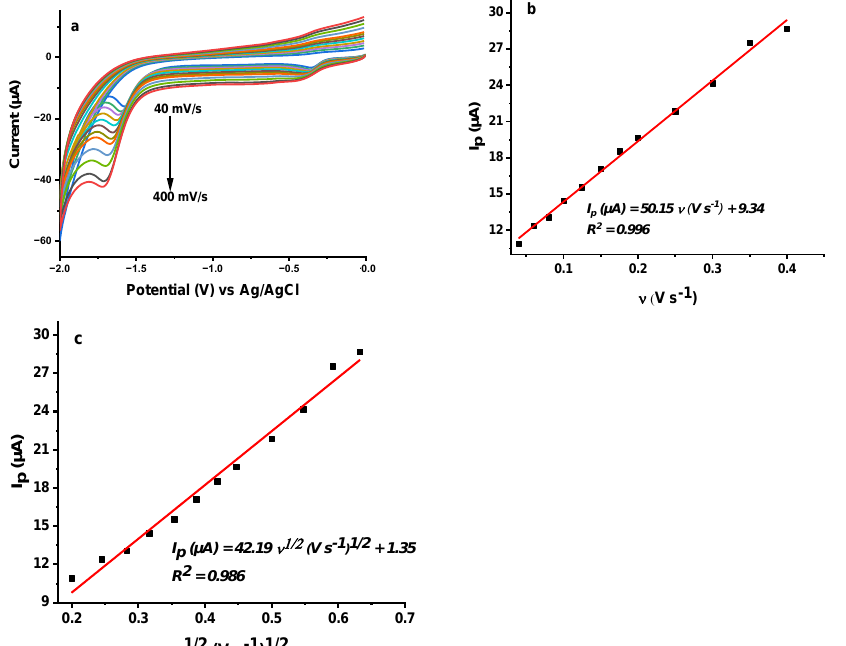
Figure 4. ( a ) cyclic voltammograms of 100 µM lindane using different scan rates in 0.2 M KCl solu- tion and reduction peak currents extracted from the voltammograms plotted against the scan rates ( b ) and against the square root of scan rates ( c ).